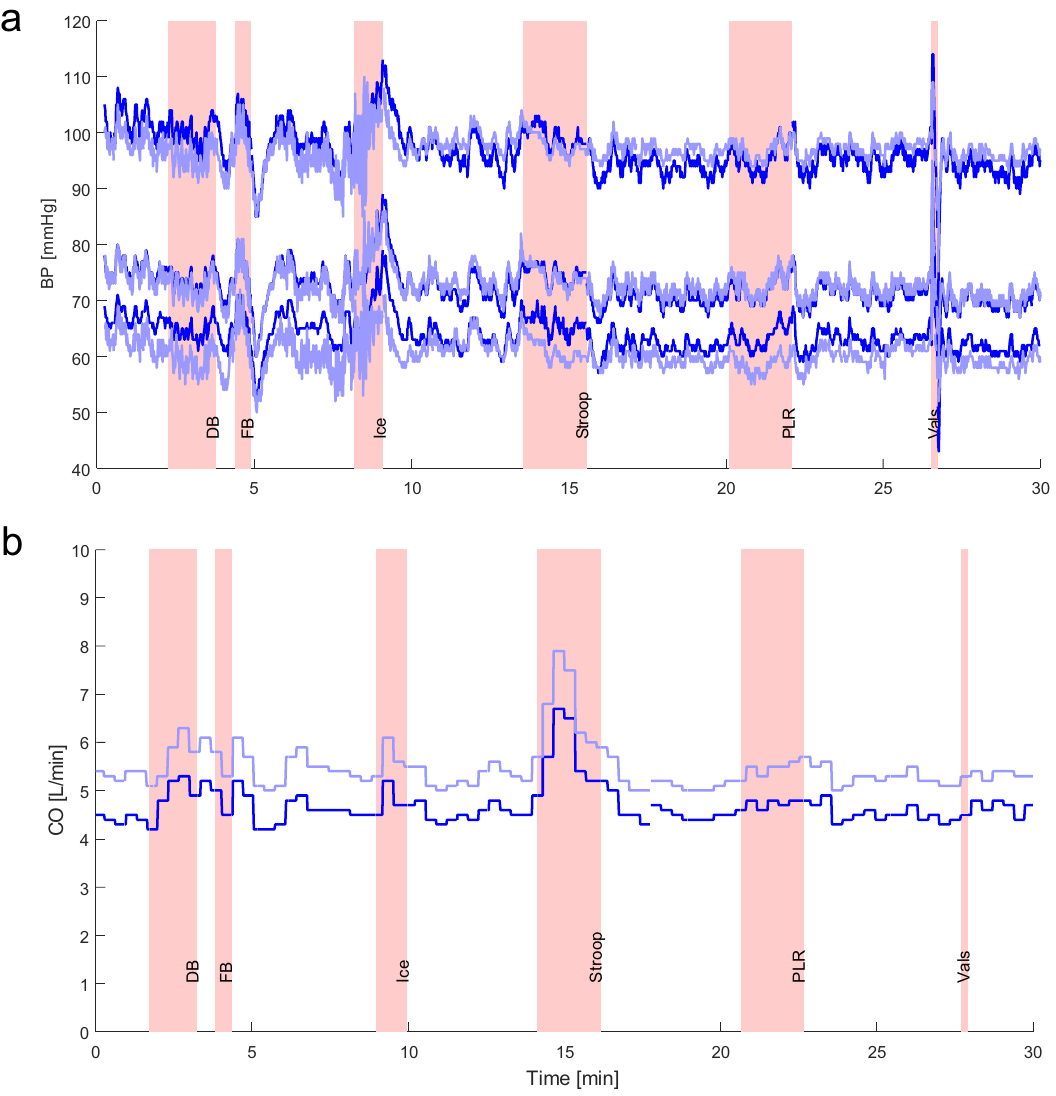
Fig. 5 Sample blood pressure (BP) and cardiac output trend traces. Data were taken from lab test measurements during physiological activities: “ DB ” : deep breathing, “ FB ” : fast breathing, “ Ice ” : submersion of hand in ice water, “ Stroop ” : color stroop test, “ PLR ” : passive leg raising, “ Vals ” : Valsalva test. a Beat-to-beat systolic, diastolic, and mean blood pressure values derived by CNAP Monitor HD (dark blue) and by CNAP2GO (light blue). b Cardiac output (CO) derived by CNAP Monitor HD (dark blue) and by CNAP2GO (light